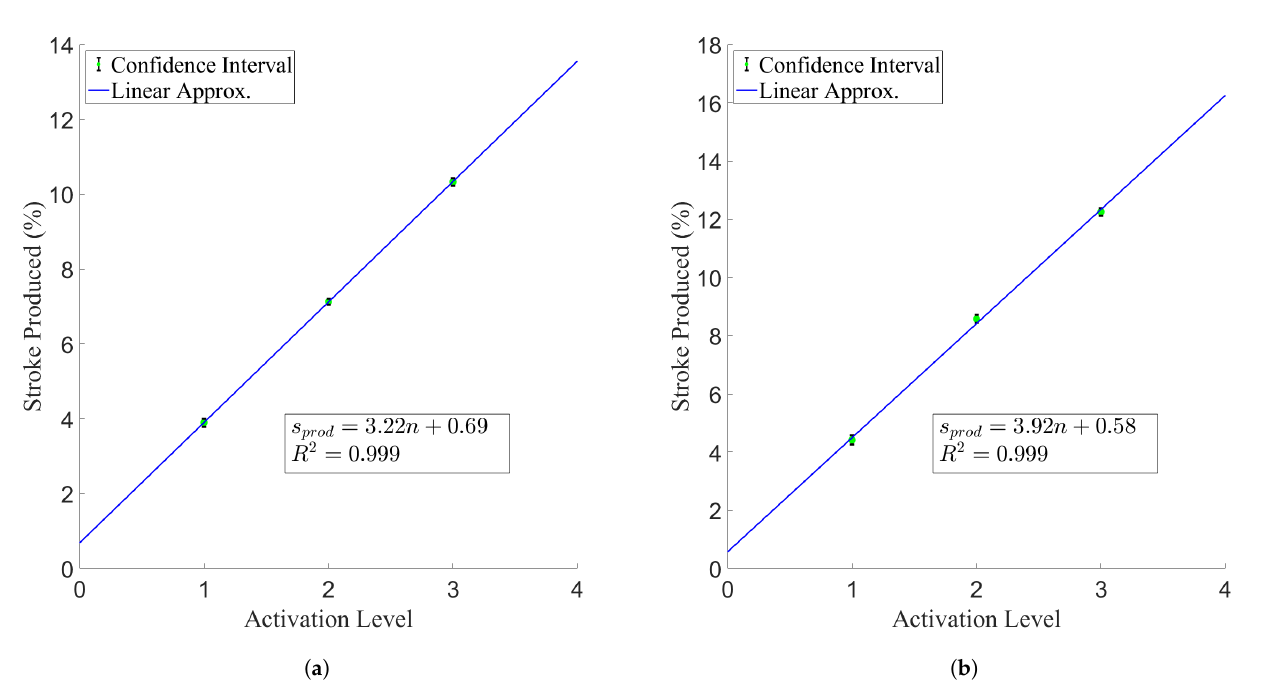
Figure 15. Maximum stroke production per active pairs of TCAs, with overlaid linear regressions. The variable n denotes number of active pairs of TCAs. ( a ) Constant contraction period experiment. ( b ) Minimum contraction period